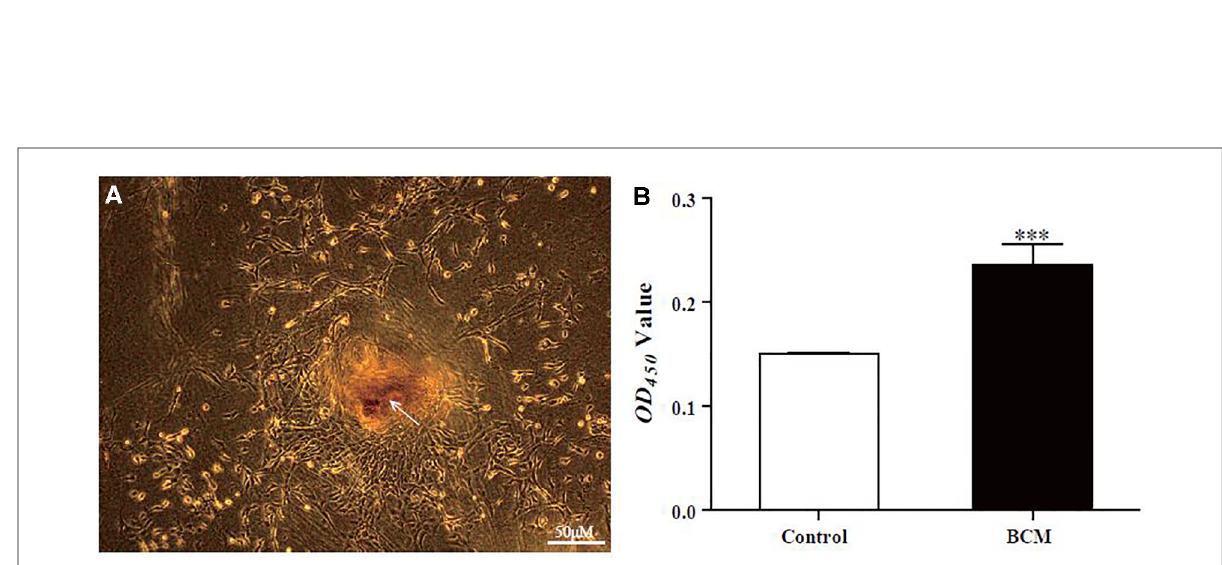
FIGURE 3 Preparation and observation of BWDs in vitro . ( A ) Observation of BWD loaded with BMSCs (bar scales=100 μ M; arrows, puncture point). ( B ) The proliferation of BMSCs seeded in the BCM was measured by CCK-8 (control: BMSCs without BCM intervention; BCM, BMSCs loaded on the BCM). Error bars represent SEM ( n =3), *** P ≤